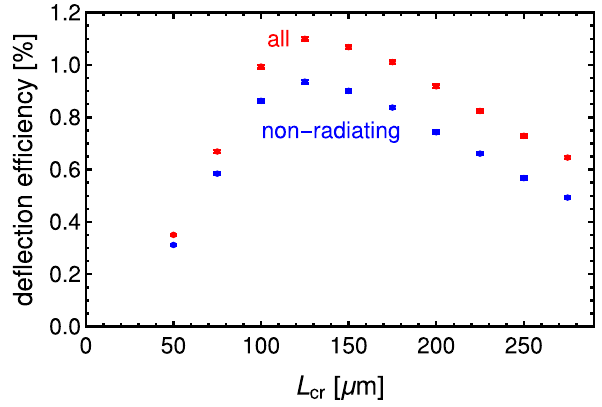
Fig. 8 Deflection efficiency as function of the crystal thickness for a Si crystal bent along the (111) planes with a deflection angle of 1.75 mrad. The lower blue dots represent the fraction of channeled particles that do not emit radiation, while for the upper red points the radiation process is possible. The incoming beam distribution is the same as in Fig. 5